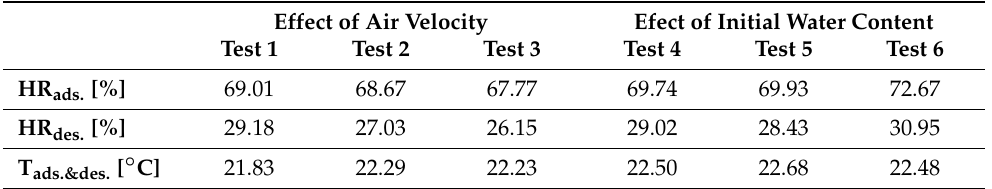
Figure 5. Ambient relative humidity [%], and temperature [ ◦ C] recorded during test 6 of MBV. Table 7. Average relative humidity [%] and temperature [ ◦ C] for all cycles (uptake/release) during each MBV test.